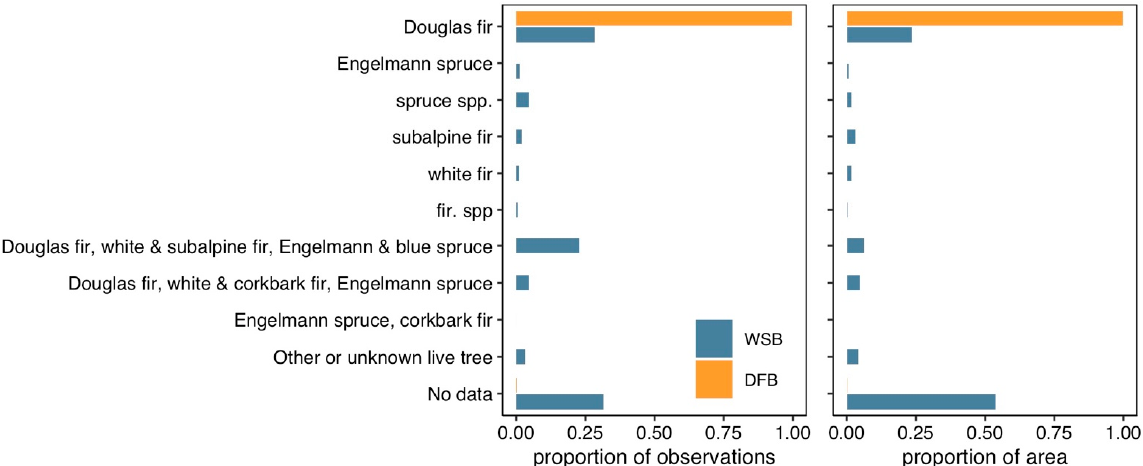
Figure A2. The proportion of ADS observations and area of ADS polygons by host identity and primary damage causing agent. In USFS Region 3, which includes New Mexico, only host groups (e.g., Douglas fir, white and subalpine fir, Engelmann and blue spruce) were recorded over the study period.